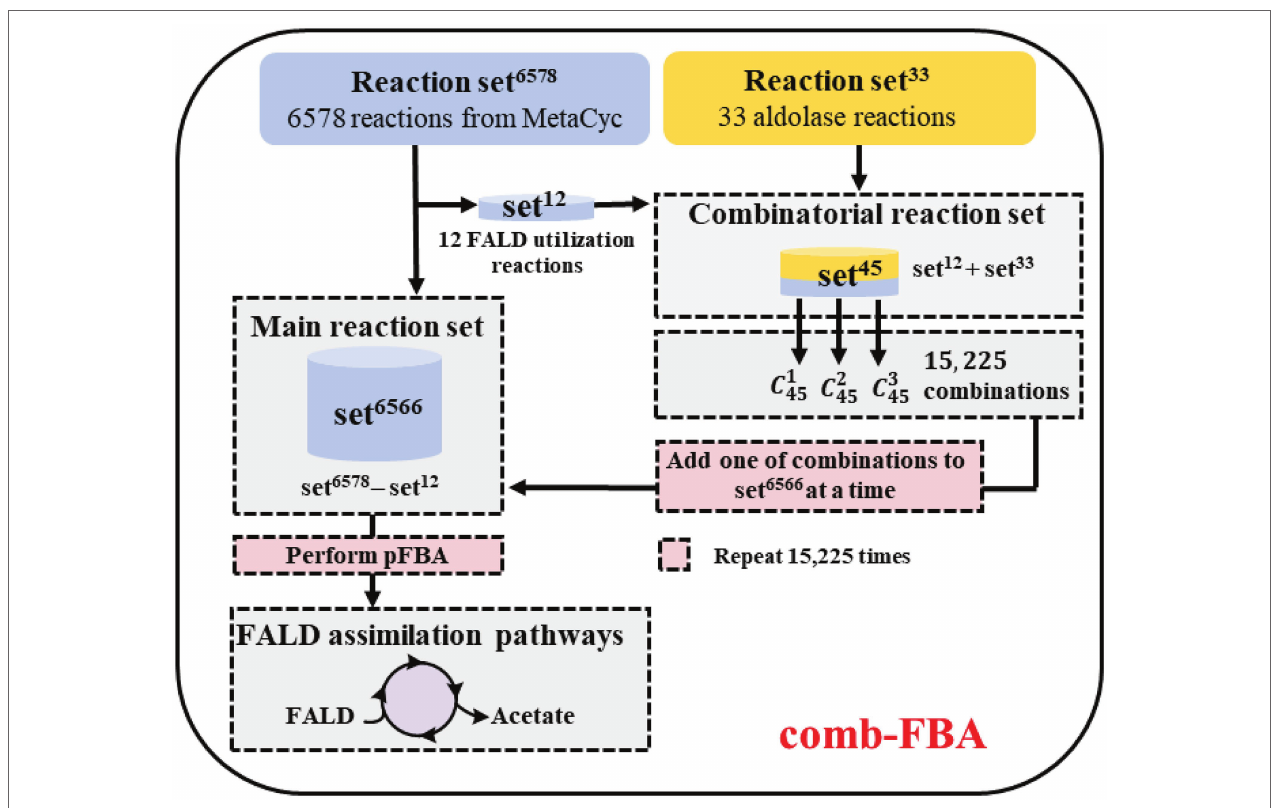
FIGURE 3 | Workflow for the calculation of formaldehyde (FALD) assimilation pathways. Comb-flux balance analysis (FBA) is performed based on two reaction sets: the main reaction set 6566 and the combinatorial reaction set 45 . In each iteration of comb-FBA calculation, a combination with one reaction ( 1 ( 2 45 C ), or three reactions ( 3 45 C ) from set 45 was added to the reaction set 6566 to predict FALD assimilation